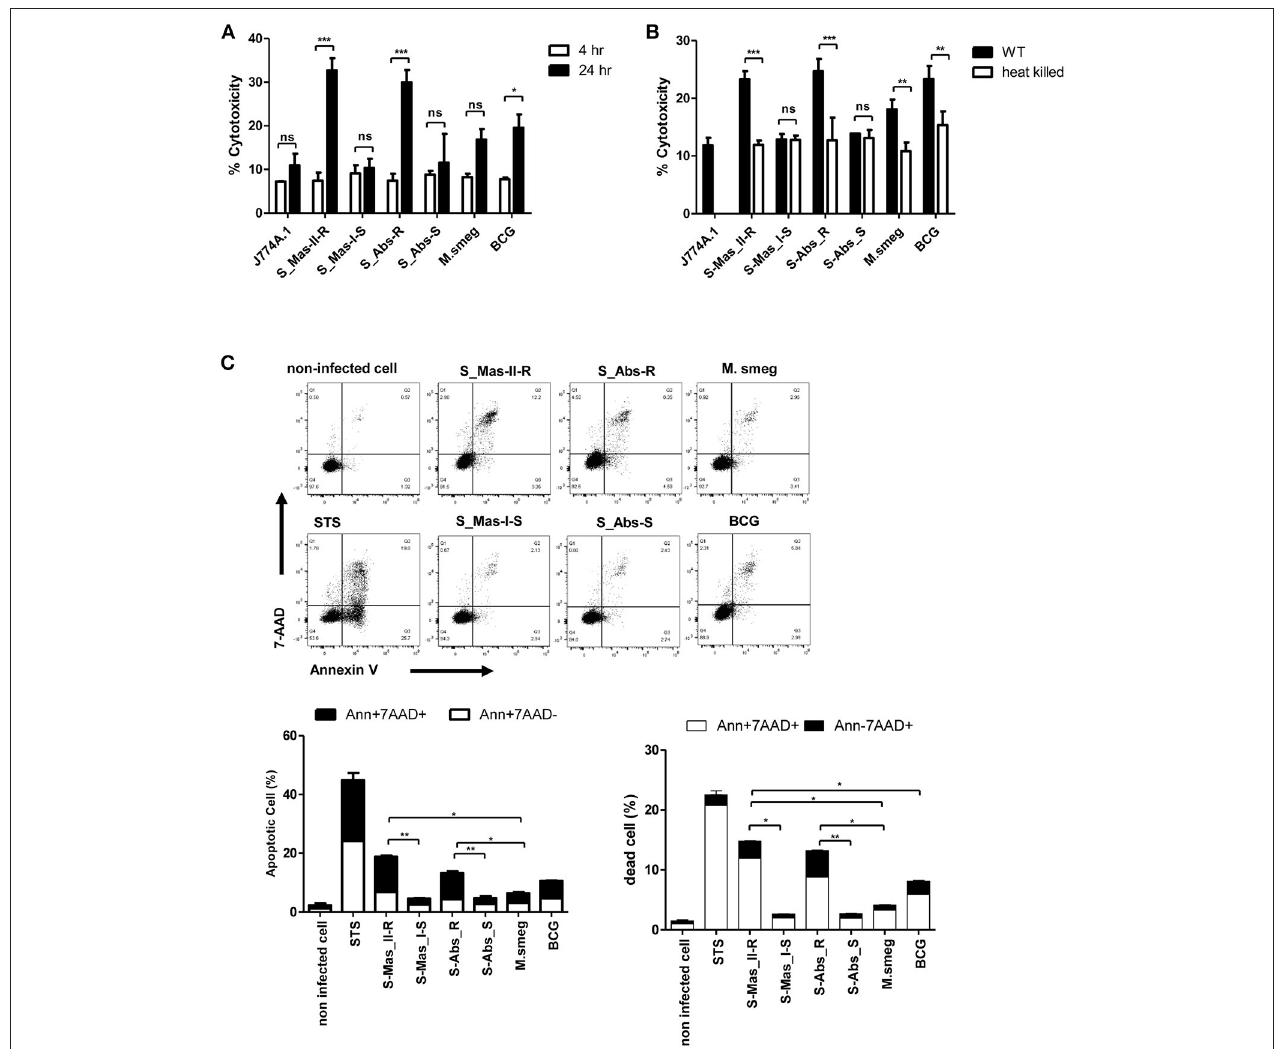
FIGURE 5 | Live MAB-R stains enhance apoptotic cell death in murine macrophage. (A) To evaluate cytotoxic effects, cells were infected with S-Mas_II-R (Asan 50594), S-Mas_I-S (Asan 51843), S-Abs_R ( M. abscessus type strain ATCC 19977 rough strain), S-Abs_S ( M. abscessus type strain ATCC 19977 smooth strain), M. smegmatis , and M. bovis BCG (10M.O.I.) in BMDM for 4 and 24h. Cytotoxicity was quantitated by measurement of LDH activity in the culture supernatants using a CytoTox 96 assay kit (Promega) according to the manufacturer’s protocol. Error bars represent the standard deviation of at least three independent experiments (* P